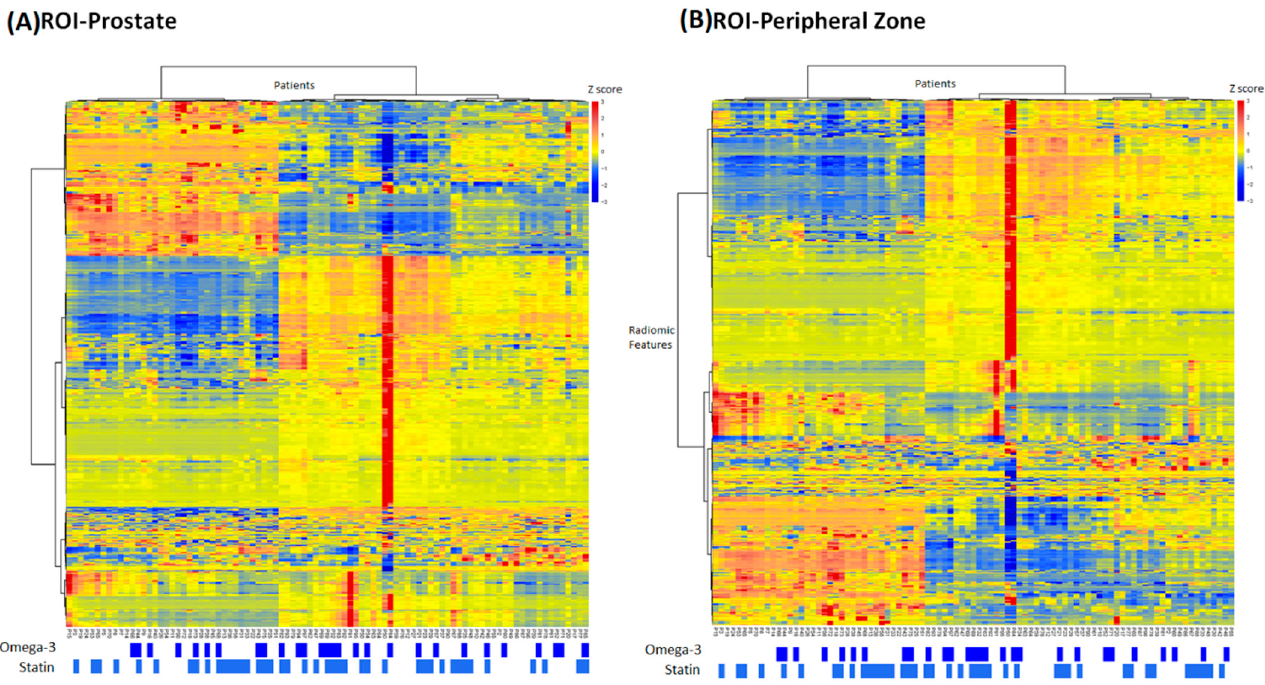
Figure 3. Heatmaps showing the radiomics feature pattern across the patient population with the usage of omega-3 and statin for ( A ) the prostate ROI and ( B ) the peripheral ROI.